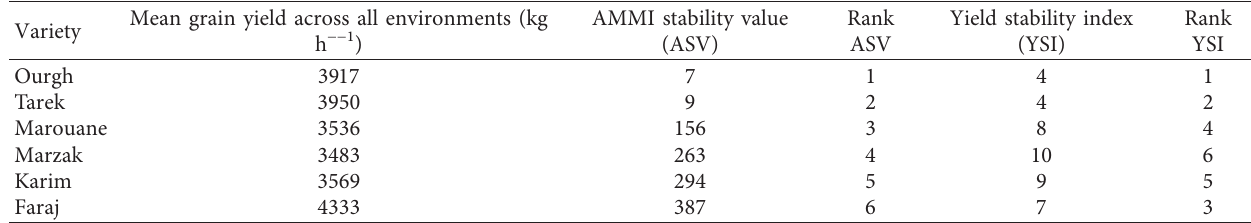
Figure 5: AMMI biplot for grain yield (kg h − 1 ) of the six Moroccan durum wheat varieties evaluated in six test environments (combination of the growing season and water regime). Rn17, rainfed 2016-17; Rn18, rainfed 2017-18; Rn19, rainfed 2018-19; Irr17, irrigated 2016-17; Irr18, irrigated 2017-18; Irr19, irrigated Table 7: Mean yield across the studies environments, AMMI stability value, and yield stability index for the studied Moroccan durum wheat varieties.